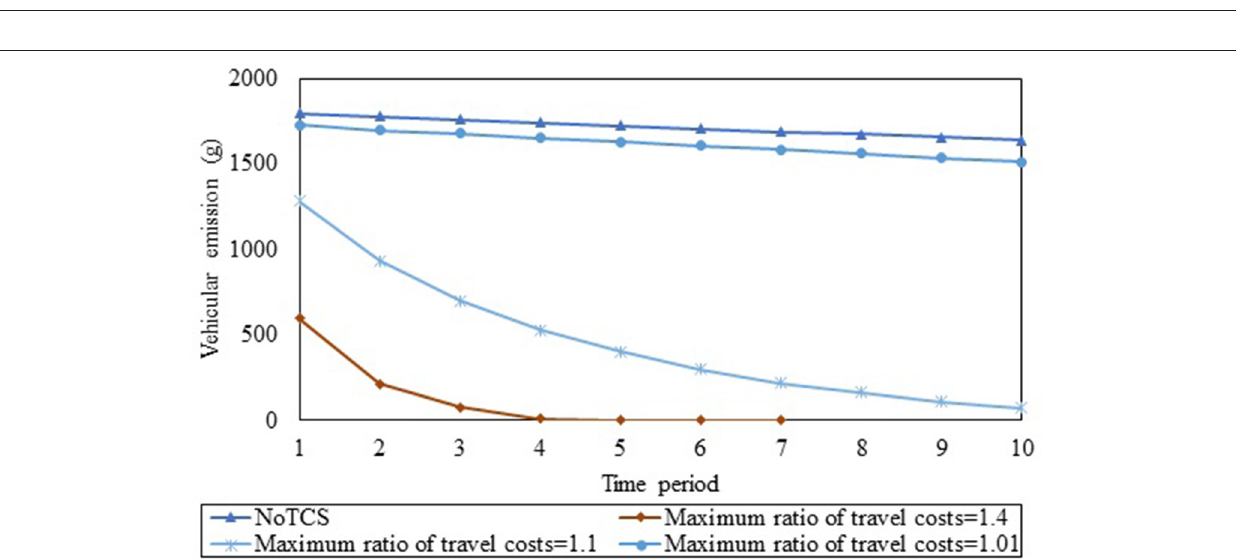
FIGURE 6 | Evolution of vehicular emissions rate through the planning horizon under different maximum ratios of the travel cost.